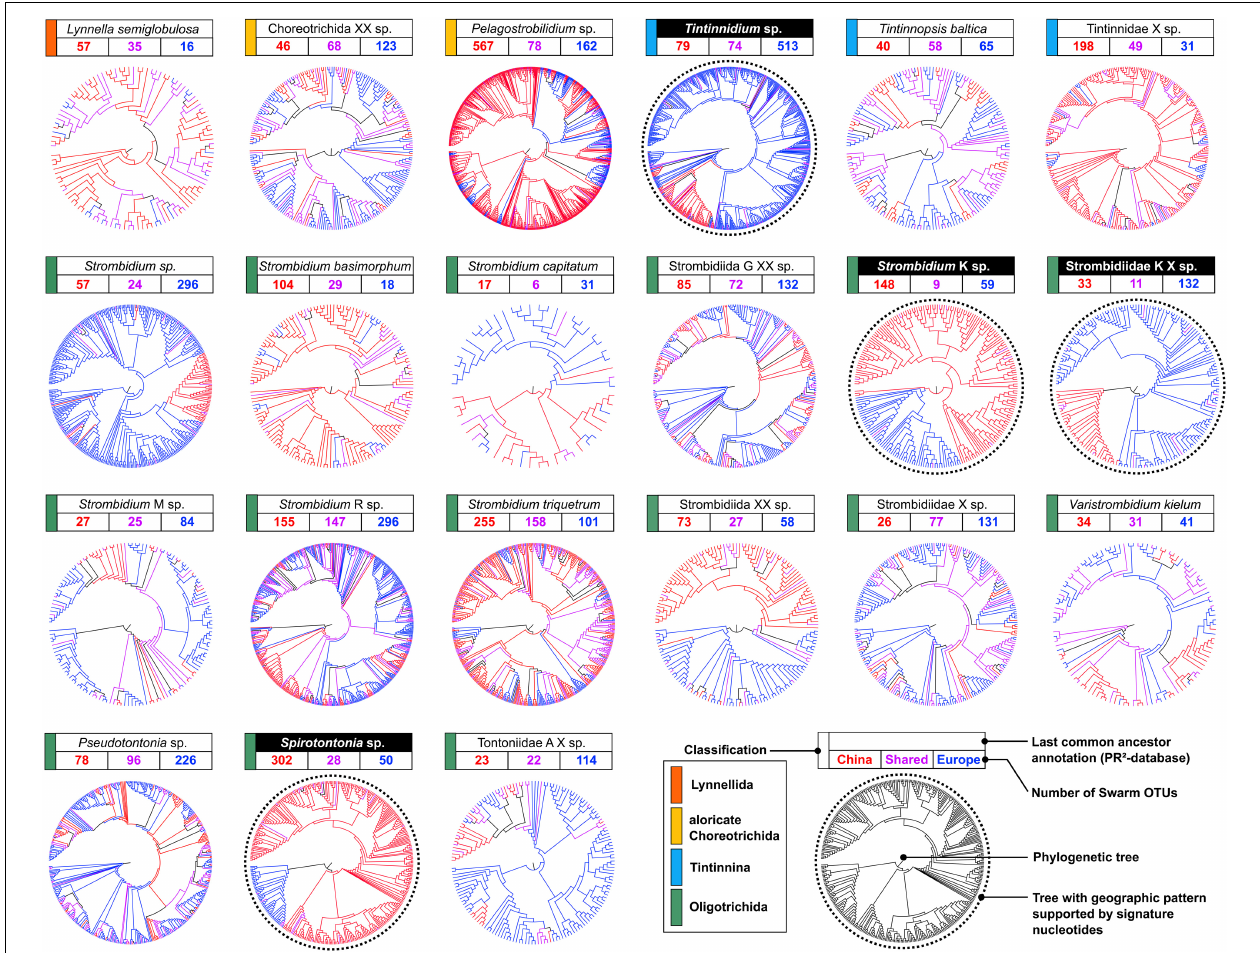
FIGURE 4 | Phylogenetic trees based on the representative sequences of the Swarm OTUs. Only trees that display a distinct geographic pattern supported by signature nucleotides are marked by “taxon” names highlighted in black and dotted